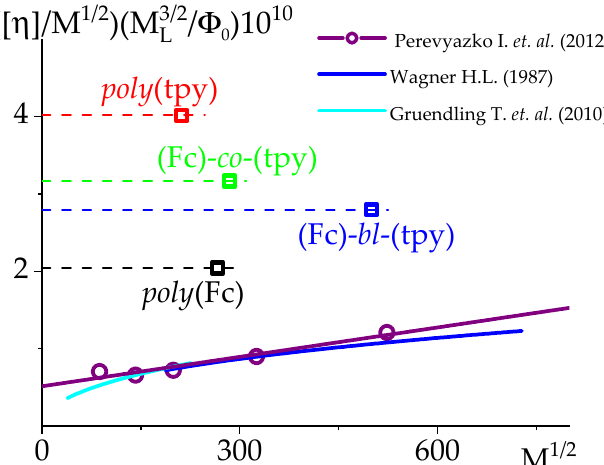
Figure 6. The application of Fixman–Stockmayer theory to the hydrodynamic data based on already published PMMA data [50,79,80] (solid lines and open circles) and its comparison with the studied samples (dashed lines and open squares). Table 4. Summary of the conformational parameters evaluated for the studied